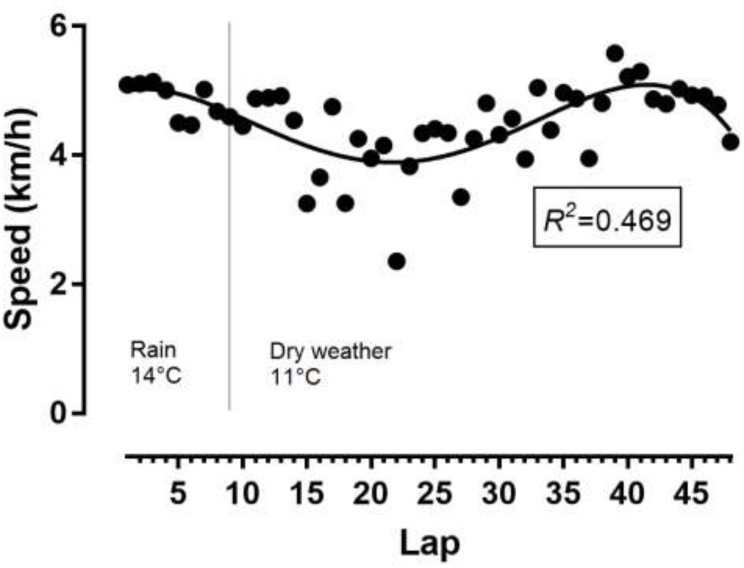
Variation of speed by lap. Temperatures referred to weather conditions during the race. R2, coefficient of determination.